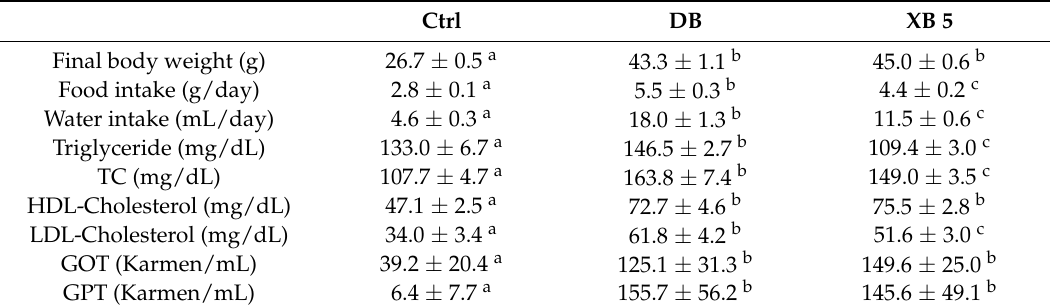
Table 3. The body weight, food and water intake, and plasma lipid profiles of mice fed different experimental diets for six weeks 1